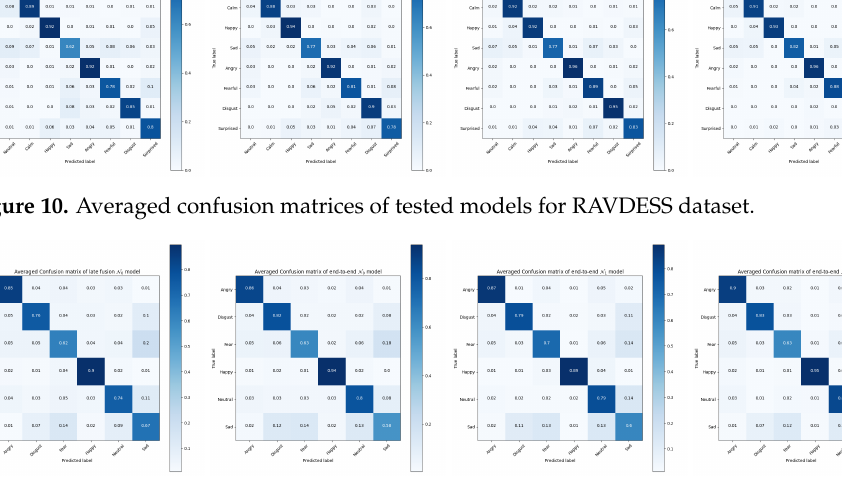
Figure 11. Averaged confusion matrices of tested models for Crema-d dataset.